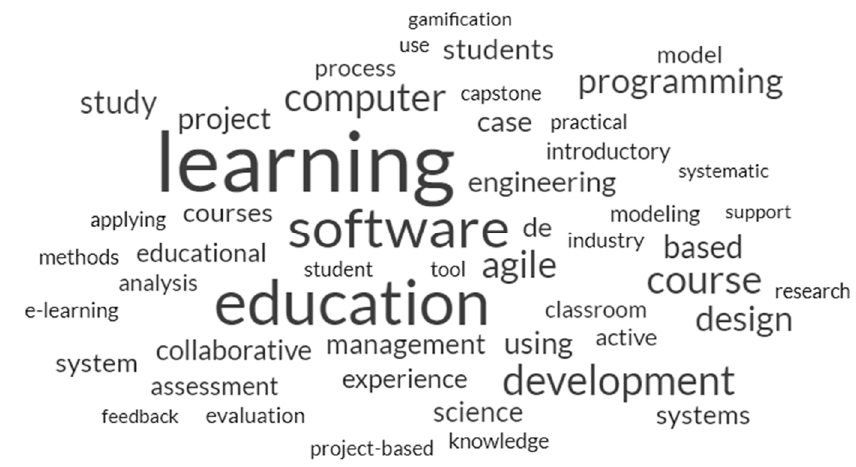
Figure 3. Tag cloud of the most representative keywords.